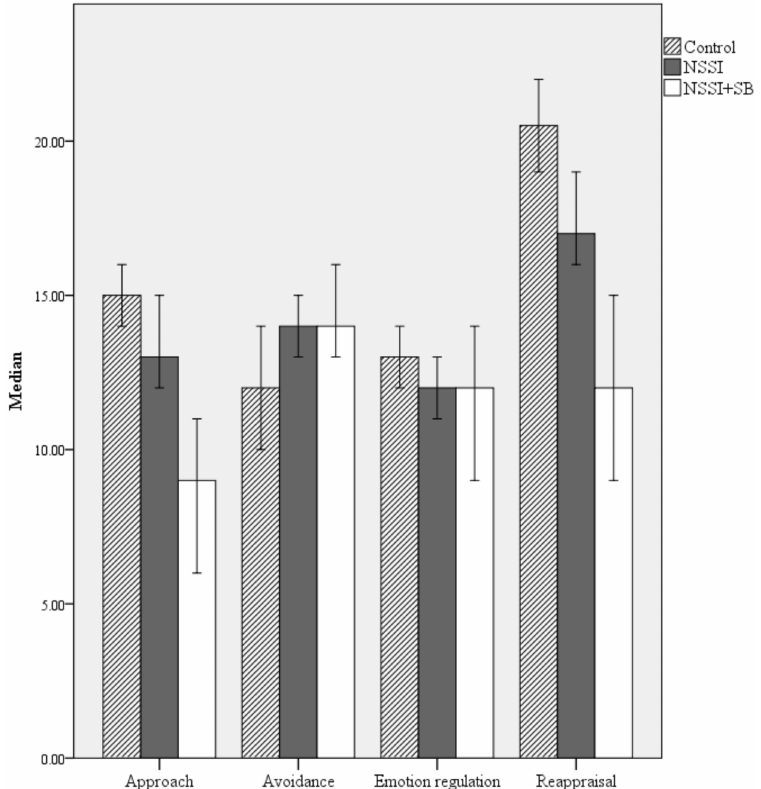
Figure 1. Median endorsement of functional coping dynamics across self-injury groups (Control vs. NSSI vs. NSSI + SB). Error bars = 95%